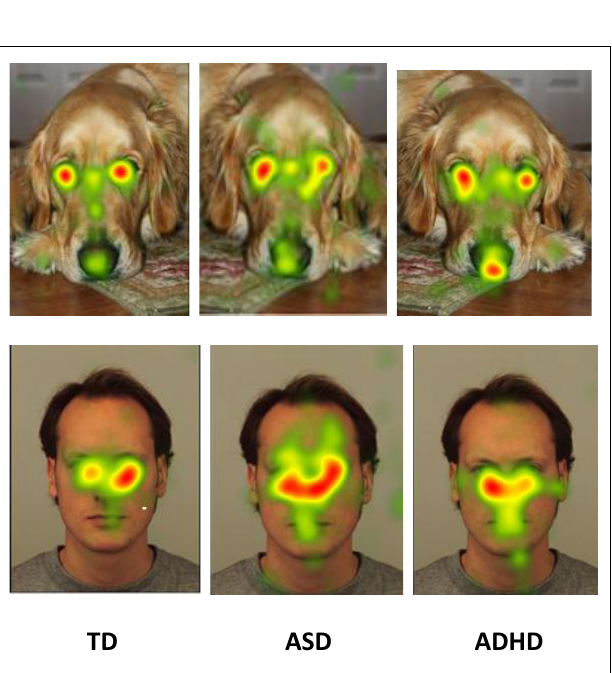
FIGURE 3 | Heat diagrams illustration of the most attended areas of animal and human faces by TD, ASD, and ADHD individuals .